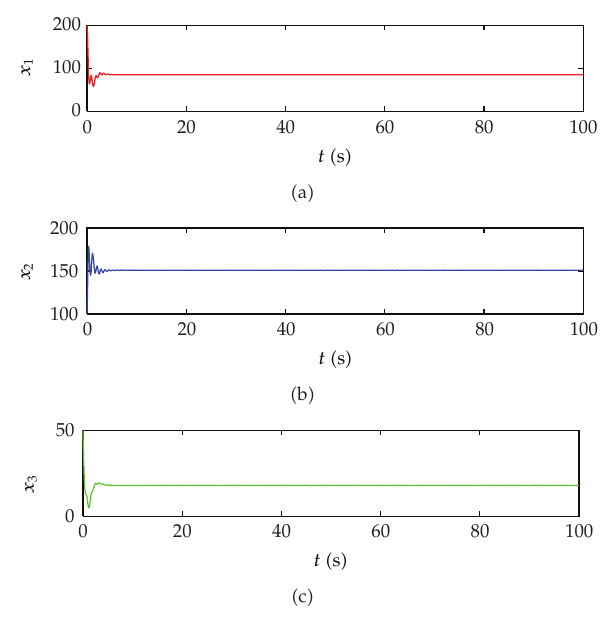
Figure 2: State variable outputs with